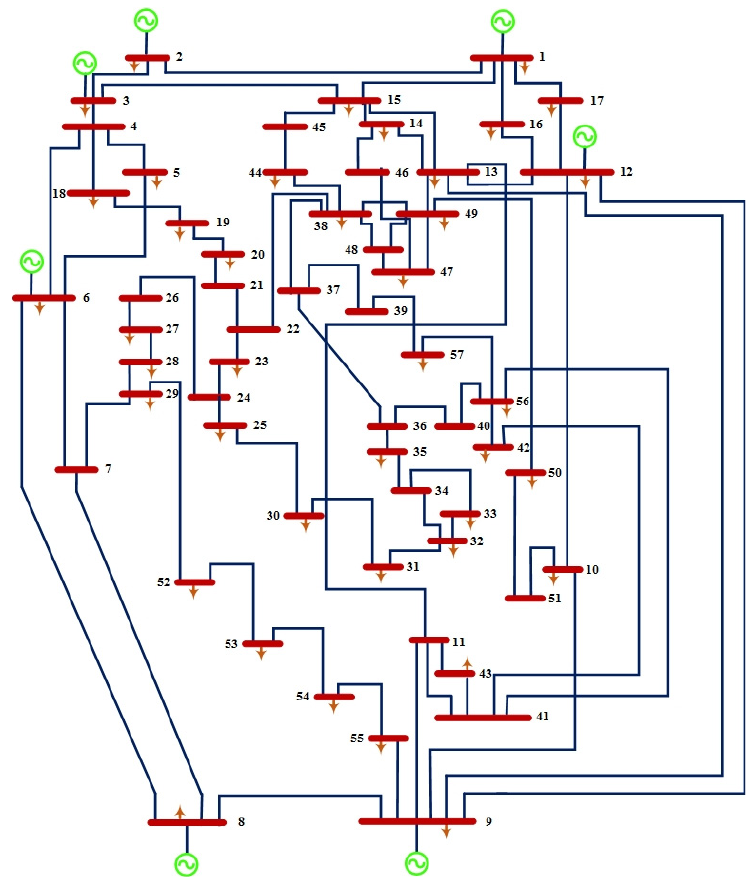
Figure 18. Standard IEEE 57 bus. Table 7. Optimal control variables for IEEE 57-bus test system for minimizing fuel cost.